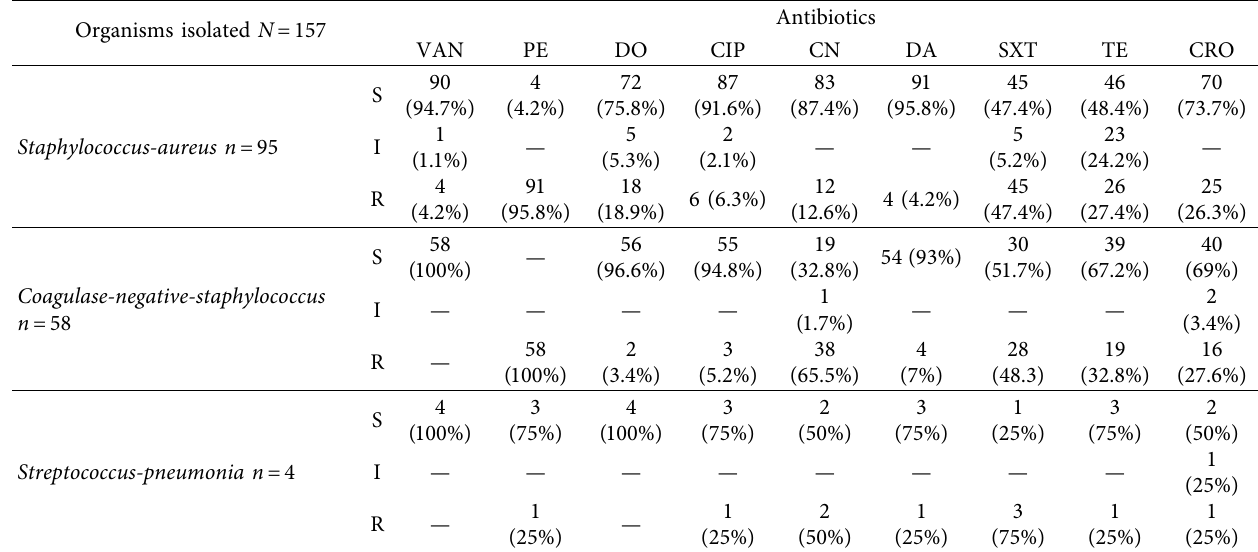
Table 5: Antimicrobial susceptibility pattern of gram-positive bacteria isolated from external ocular infection at Karamara hospital, Jigjiga, eastern Ethiopia, 2020.